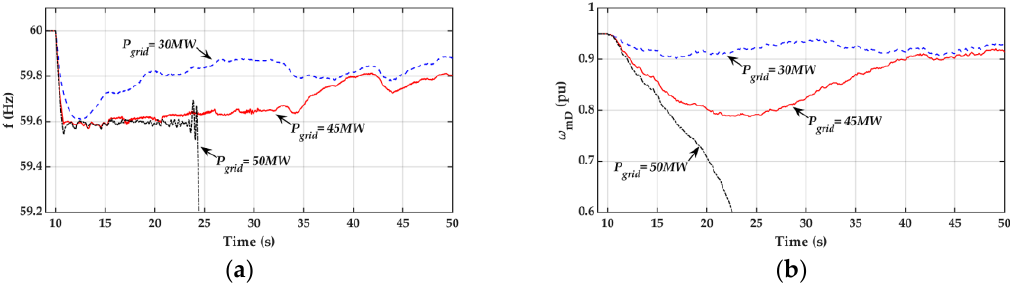
Figure 14. Dynamic response curves of the Type II controller under parameters uncertainties and the fluctuation of wind speed at different deficit powers. ( a ) Frequency, ( b ) DFIG speed.